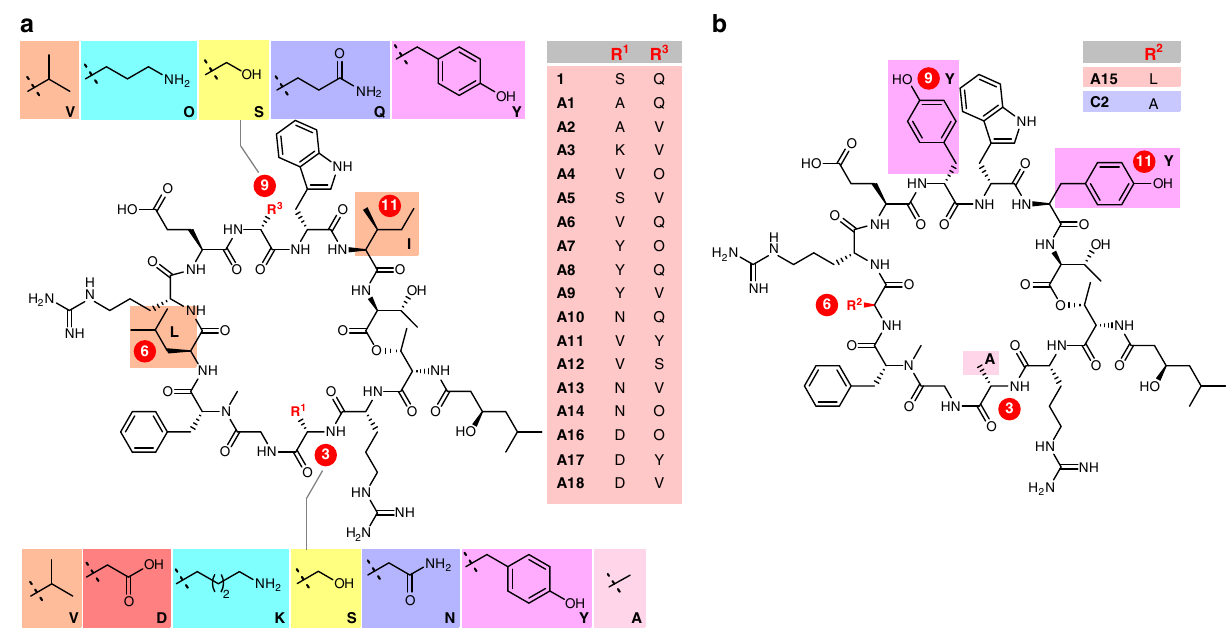
Fig. 5 Structures of lysocin E and 19 analogues. a Structures of 1 and its antimicrobial analogues A1 – A14 and A16 – A18 . b Structures of antimicrobial analogue A15 and non-antimicrobial analogue